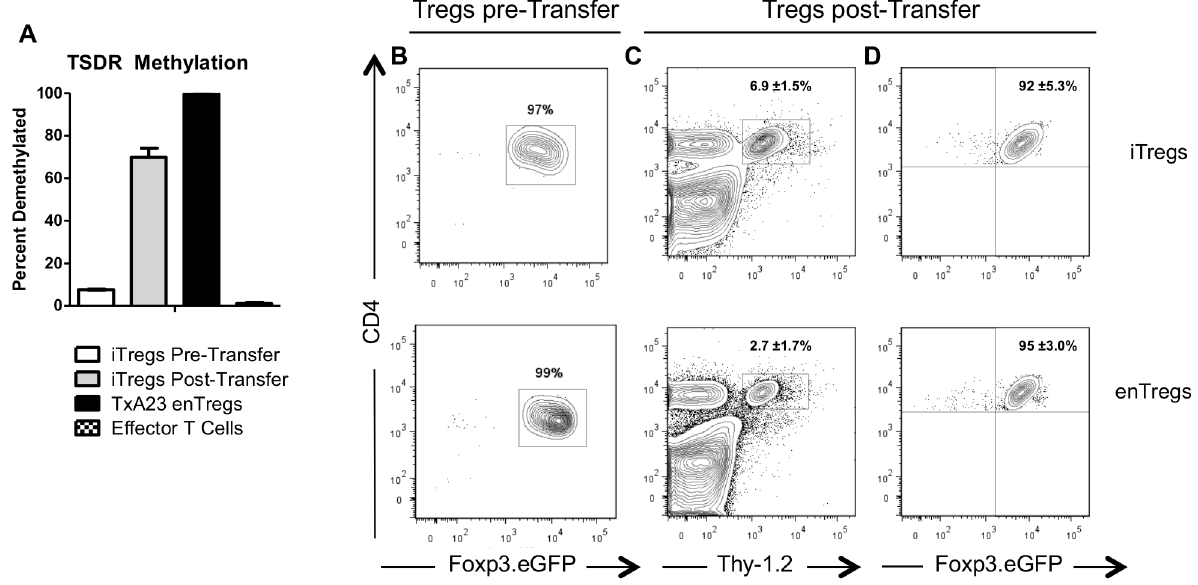
Figure 1. iTregs demethylated the Treg specific demethylated (TSDR) region and maintained Foxp3 expression. (A) The methylation status of the Foxp3 TSDR of iTregs prior to and after transferring into TxA23 mice. Also shown are enTregs (CD4 + Foxp3 + ) and conventional (CD4 + Foxp3 - ) cells from TxA23 mice. Flow cytometric analysis of (B) the purity of enTregs and iTregs prior to transferring into TxA23 mice, (C) the percentage of Thy1.2 + transferred Tregs in the gastric mucosa, and (D) the expression of Foxp3.eGFP by the Thy1.2 + Tregs one week after transfer. Data shown represents 2 mice for the enTreg group and 3 mice for the iTreg group from two independent experiments.